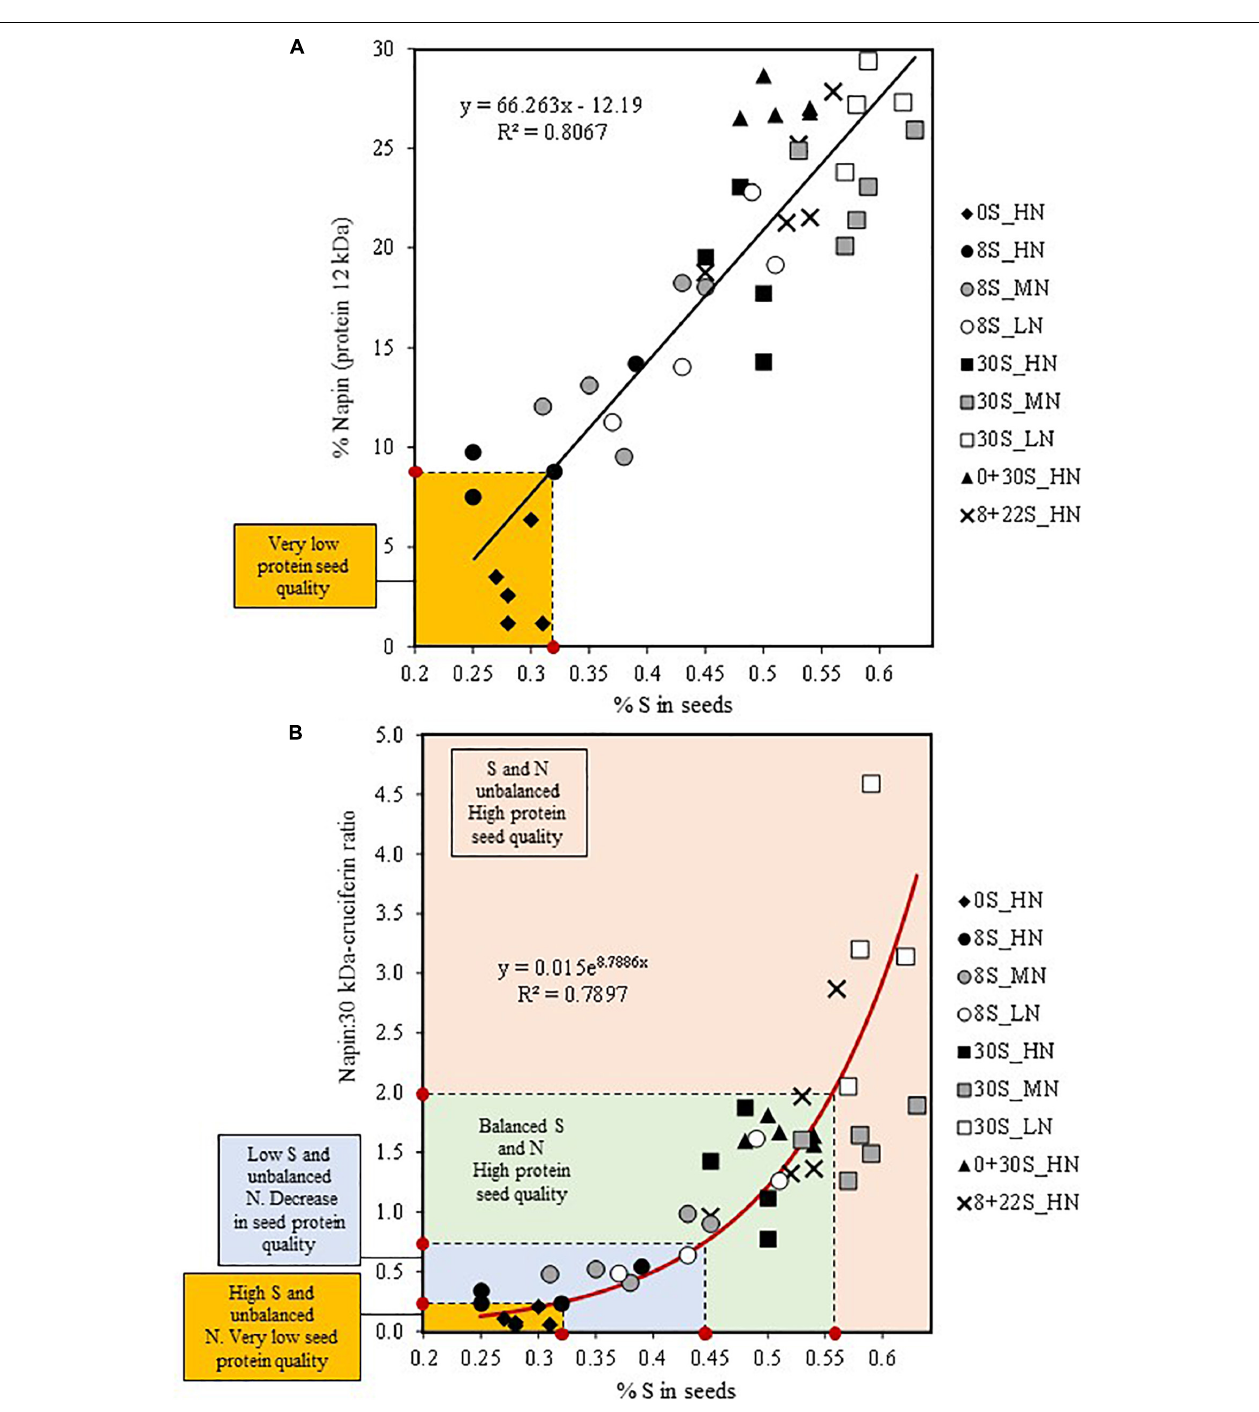
FIGURE 6 | Relationship between the relative S content (% S) and the relative abundance of napin (S-rich SSP of 12 kDa) in mature seeds (A) and the relative S content (%S) and the napin:30 kDa-cruciferin ratio (B) . Data corresponding to the different S and N fertilization combinations were plotted to determine the correlation ( n = 41, p < 0.0001, RMCE =